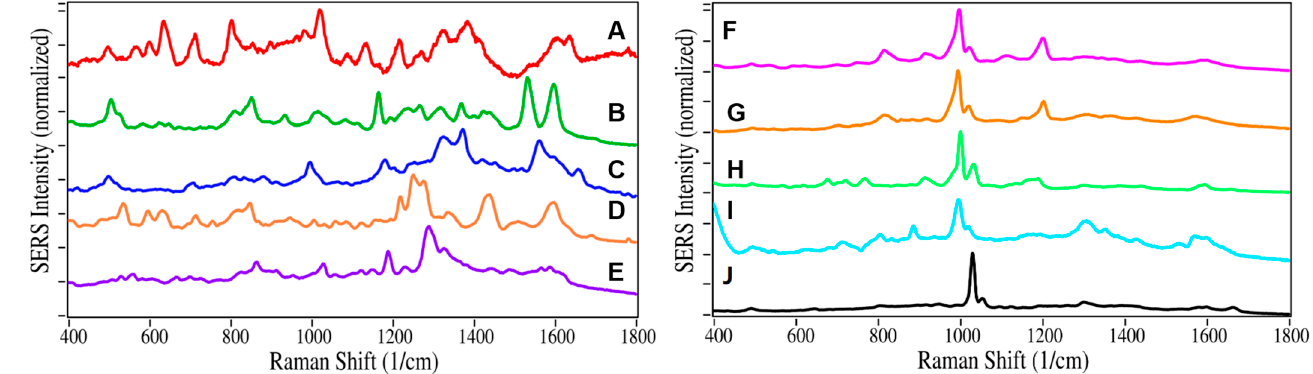
The uncorrected buprenorphine concentrations are shown in parentheses. a = Abbreviations: ACE- acetaminophen, AMP-amphetamine, BUP-buprenorphine, CAN-cannabinoids, COC-cocaine, COC-ET-cocaethylene, COD-codeine, MAMP-methamphetamine, MDON-methadone, MOR-mor- phine, NIC-nicotine, NOR-norbuprenorphine, OPI-opioids, UNK-unknown biochemical, chemi- cal, or drug, Y = yes, b = cannabinol, c = delta9 THC.